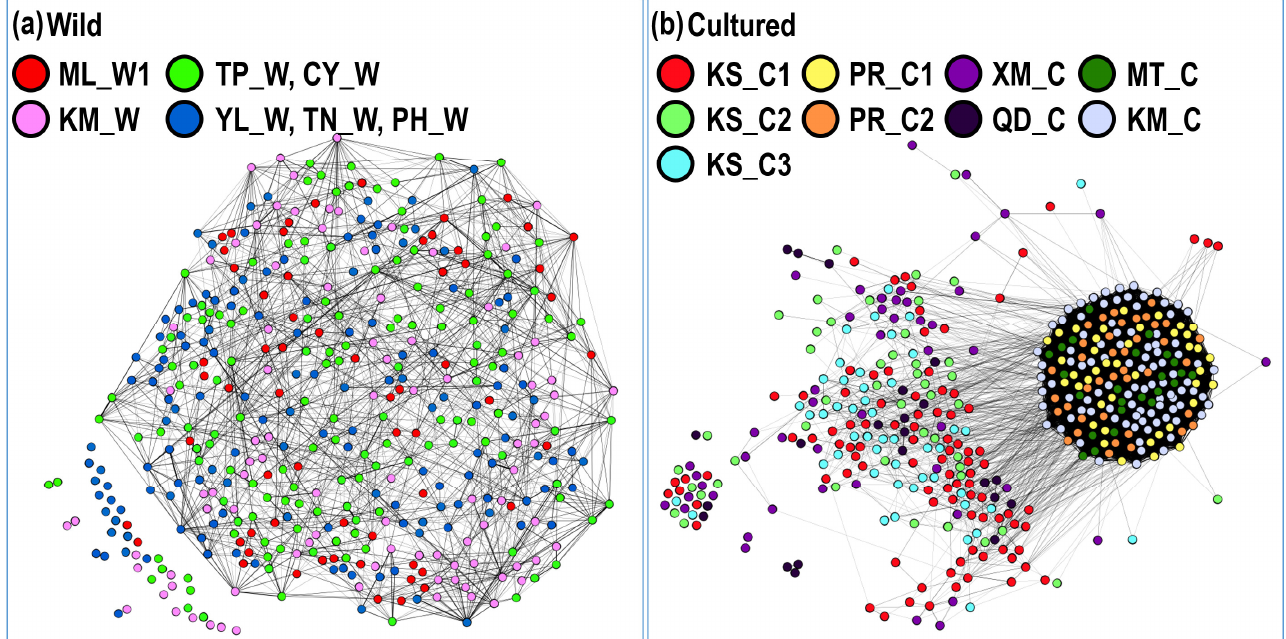
Figure 5. Kinship network based on pairwise relatedness: ( a ) seven wild populations and ( b ) nine cultured populations. Wild populations: ML_W1, YL_W, PH_W, TN_W, TP_W, KM_W, and CY_W; Cultured populations: KS_C1, KS_C2, KS_C3, PR_C1, PR_C2, KM_C, and MT_C. Pairwise relatedne ® (r) > 0.4.